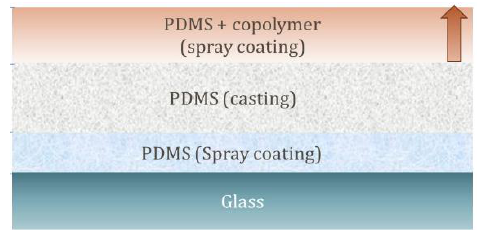
Figure 1. Schematic representation of three-layer PDMS-based films.